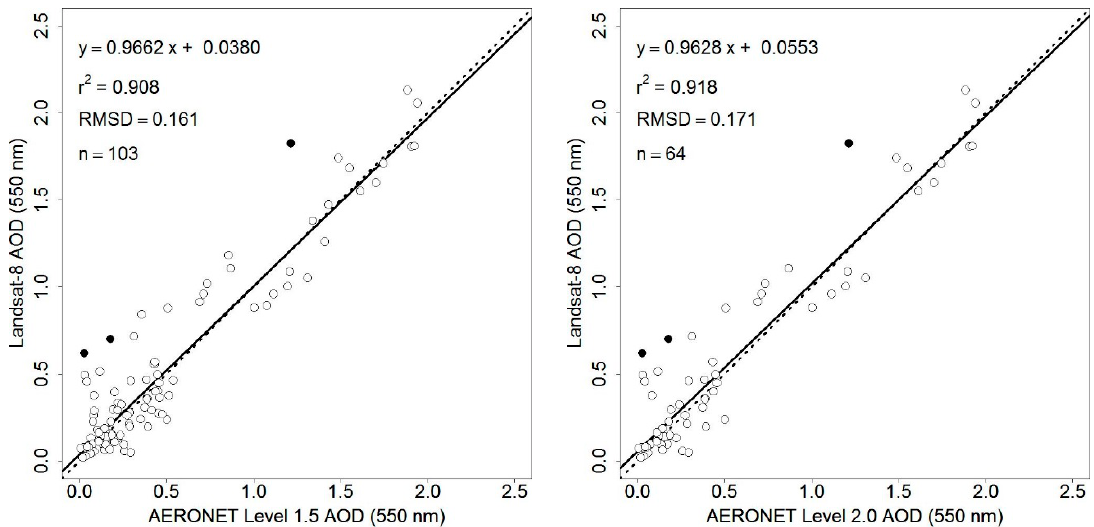
Figure 3. Scatterplots of the Landsat-8 AOD against the contemporaneous AERONET Level 1.5 (left) and Level 2.0 (right) AOD data over the urban AERONET sites for 2016. The three filled circles are outliers due to Landsat-8 cloud detection omission errors and are not used in statistics analysis. The solid lines show ordinary least square regression lines. The dotted lines are 1:1 lines superimposed for reference.